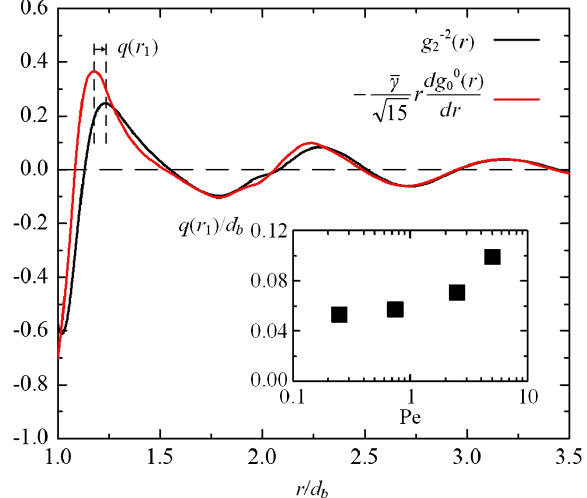
ffiffiffiffiffi p 15 Þ rdg 0 0 ð r Þ =dr and g − 2 2 ð r Þ